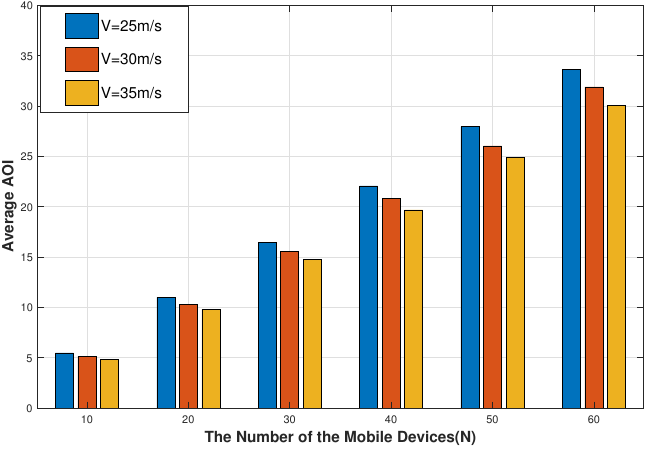
Figure 9. The impact of different speeds of the UAV on average AoI.